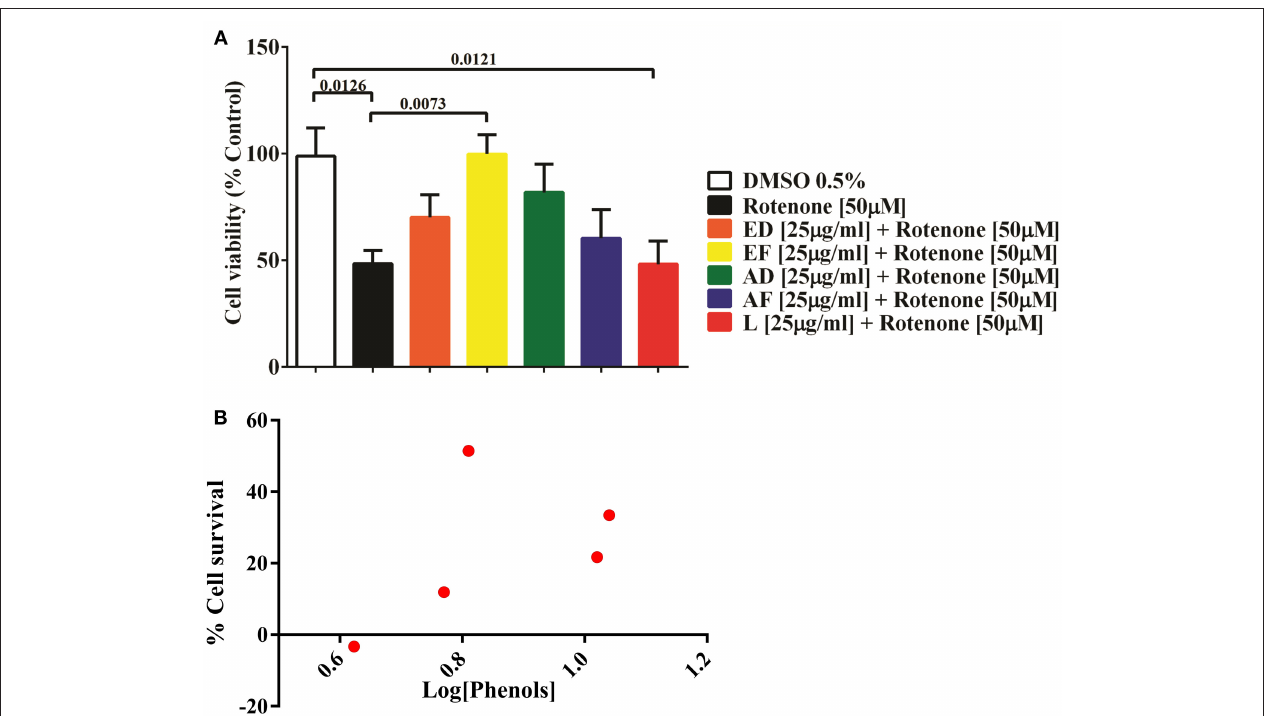
FIGURE 1 | Effect of extracts of Physalis peruviana on the viability of T98G cell. (A) Percentage of survival of T98G cells measured by MTT against the toxic effect of 50 µ M rotenone for 24h and simultaneous treated with extracts EF, ED, AF, AD, and L (25 µ g/ml). A 52% decrease in cell survival ( p = 0.0126) was detected after exposure to rotenone. In the co-treatment with EF extract, cellular survival was increased in 51% ( p = 0.073), followed by AD extract in 33% ( p = 0.1290), ED in 21.7% ( p = 0.4839), AF in 11.9% ( p = 0.8990). There was no significant effect of the lyophilized extract. (B) Correlation of the phenol content and percentage of cell survival of the extracts EF, ED, AF, AD, and L before the insult with 50 µ M rotenone. The content of phenols in the extracts EF, ED, AF, AD, and L was determined by the Folin-Ciocalteu method.